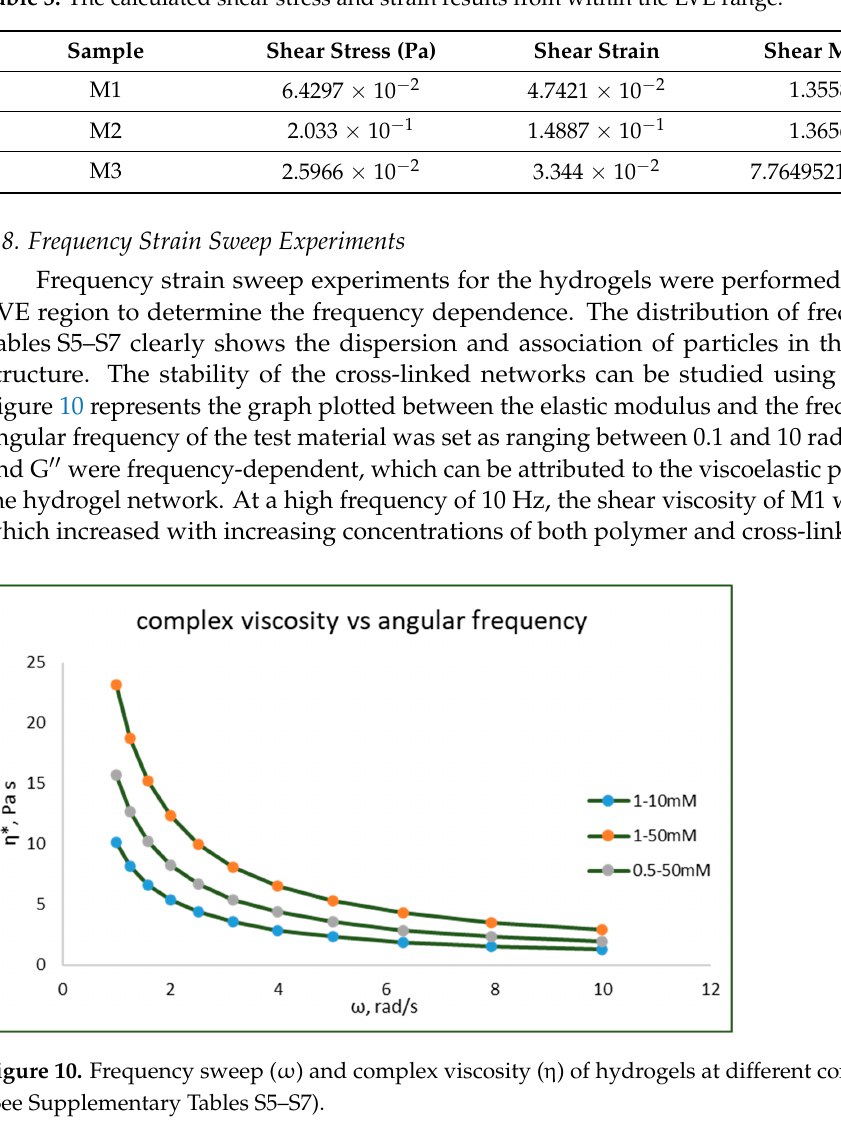
Table 3. The calculated shear stress and strain results from within the LVE range. Sample